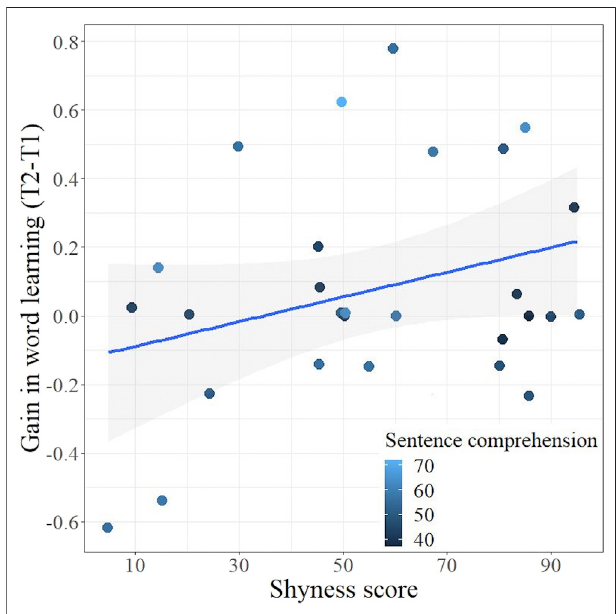
FIGURE 4 | Scatterplot with linear regression line (including 95% con fi dence interval) illustrating the predictive relation between level of shyness and gain in word learning (difference scores of word learning between T2 and T1). Receptive linguistic skills are integrated as converted percentile